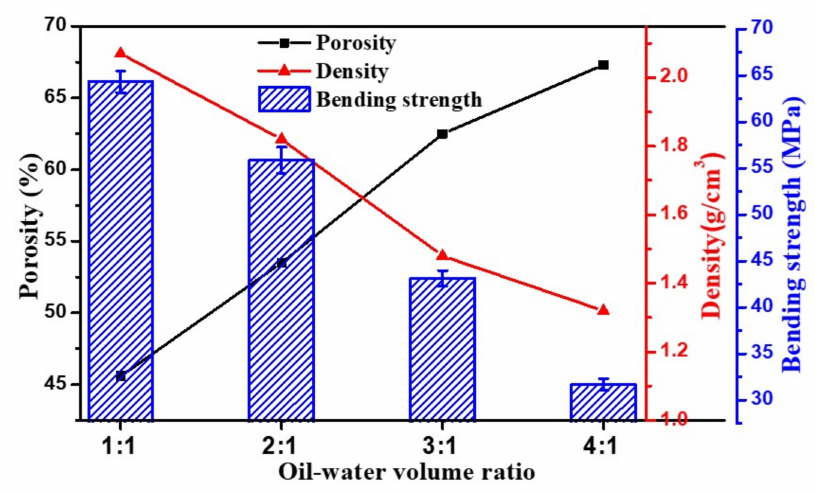
Figure 3. Porosity, density, and bending strength of sintered samples with oil–water volume ratios of 1:1, 2:1, 3:1, and 4:1.